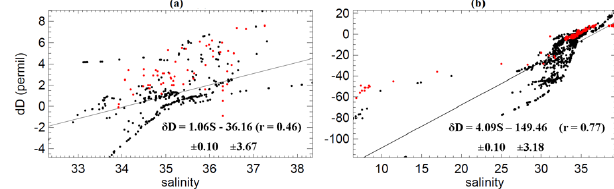
Fig. 11. Relationship between δ 18 O and salinity S for simulated and observed surface waters. (a) Tropical regions, (b) extra-tropical regions. In all panels, model results are plotted in black and obser- vational data are plotted in red. The regressions are calculated from simulation results, the corresponding observational regressions are given in text. For the model-data comparison, only those model grid cells that contain observations are chosen. If several observed data values exist in a corresponding grid cell, the mean of all data values is used for the analyses.